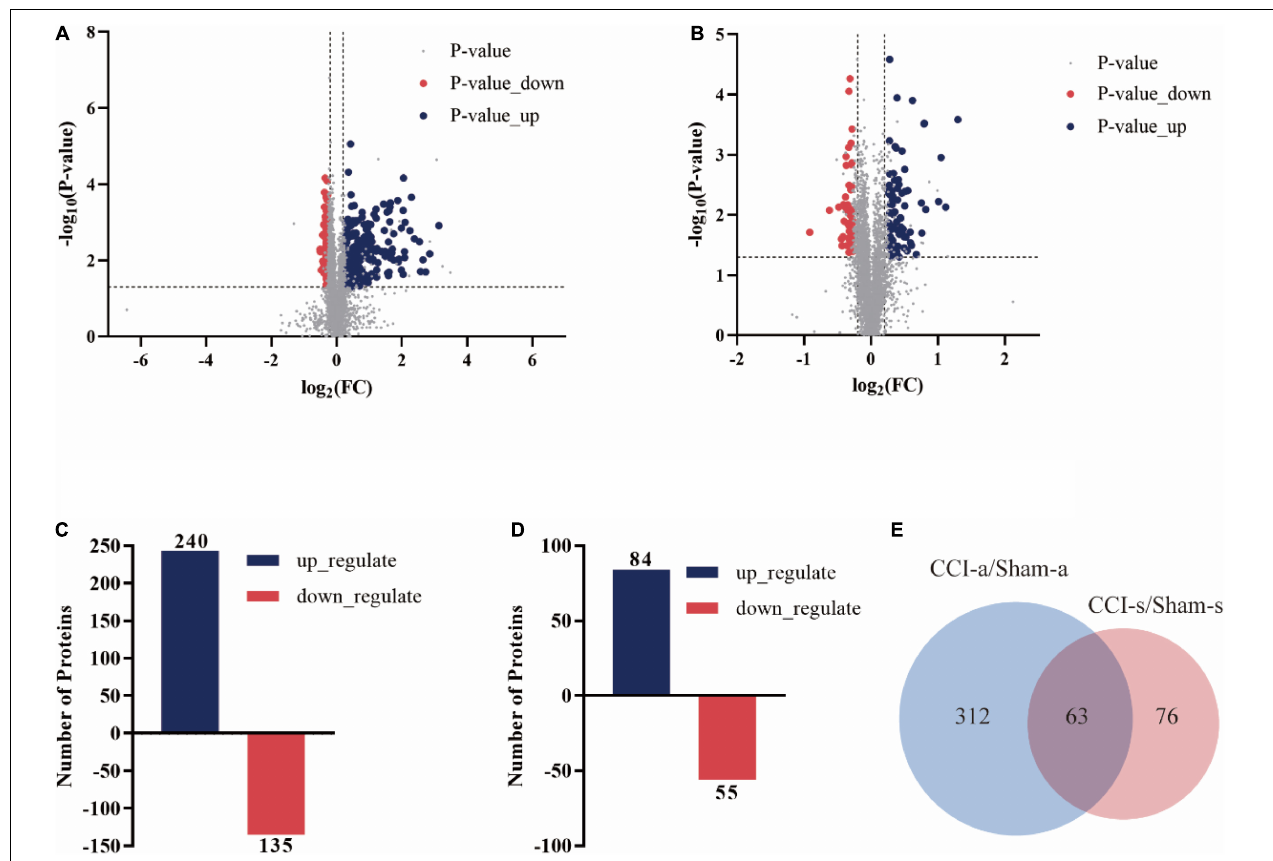
FIGURE 5 | Differentially expressed proteins of CCI rats in the hippocampal tissues on days 3 and 14 of TBI. The volcano plot showed the DEPs, up-regulated (blue) and down-regulated (red) between Sham-a/CCI-a groups (A) and Sham-s/CCI-s (B) groups of 5535 proteins: unique peptides (cid:61) 2; p -value < 0.05; FC > 1.2 or < 0.83. (C) DEPs in the Sham-a/CCI-a groups (240 up-regulated; 135 down-regulated). (D) DEPs in the Sham-s/CCI-s groups (84 up-regulated; 55 down-regulated). (E) Venn diagram of stage-specific DEPs and the shared DEPs of acute and recovery phases of